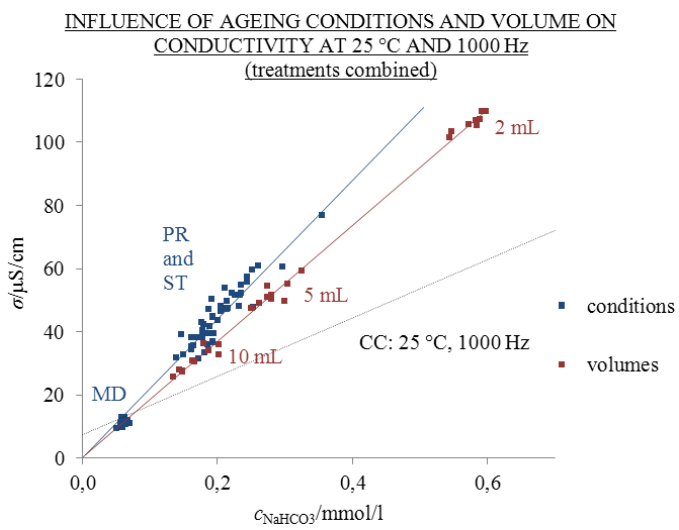
Figure 11. Conductivity at 25 °C and 1000 Hz as a function of c and aged solutions. Ageing for 310 days in 2 mL of 2.5 mL flasks under conditions PR, ST and MD (blue) and ageing for 370 days in 2, 5 and 10 mL of 20 mL flasks (red). Points in the graph represent individual measurements. Conductivity above CC is